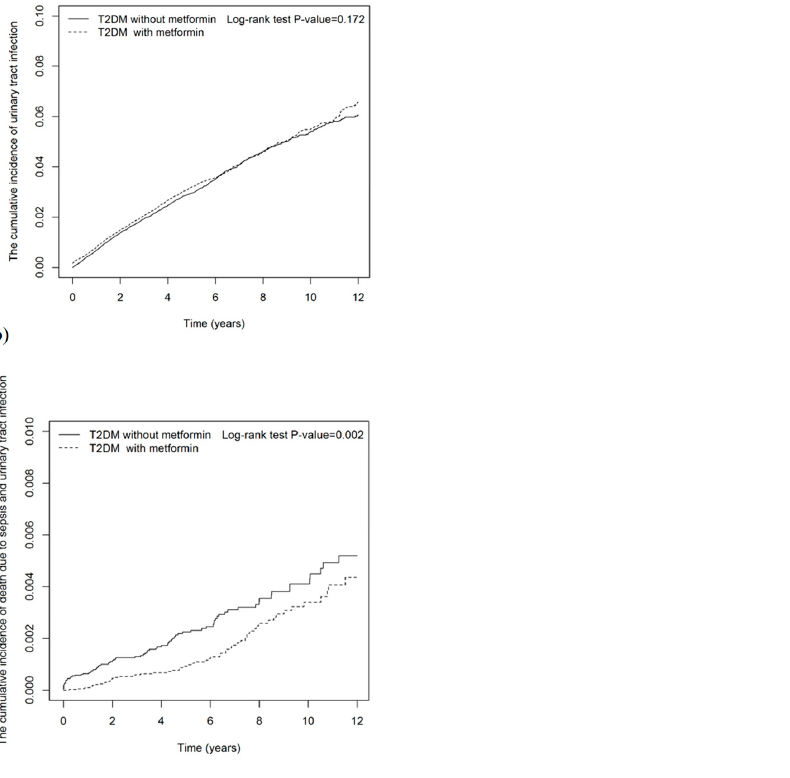
Figure 2. Cumulative incidences of ( a ) urinary tract infection (UTI), ( b ) death due to UTI or sepsis, for metformin users vs. metformin nonusers.